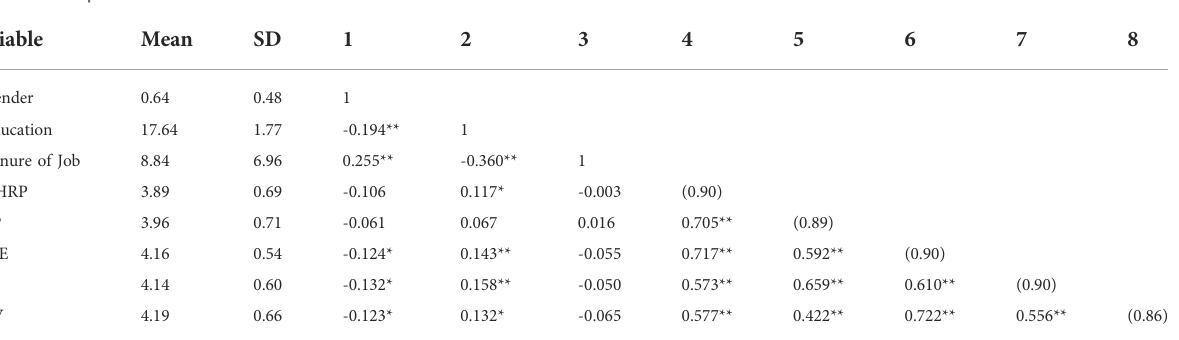
TABLE 1 Descriptive statistics and correlation matrix.